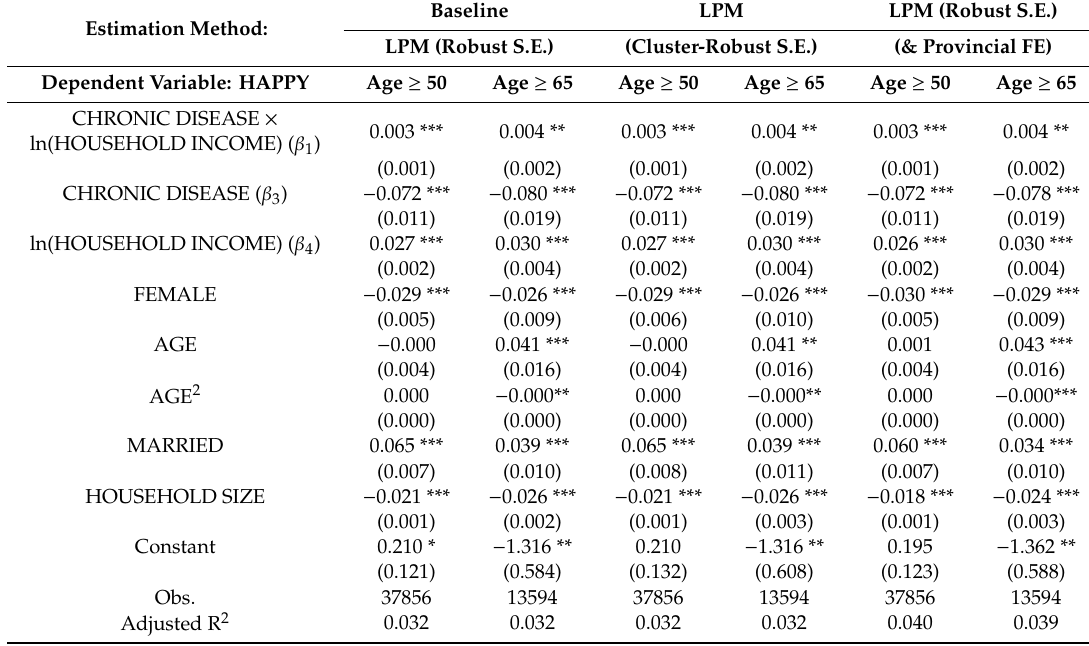
Table 2. Estimation